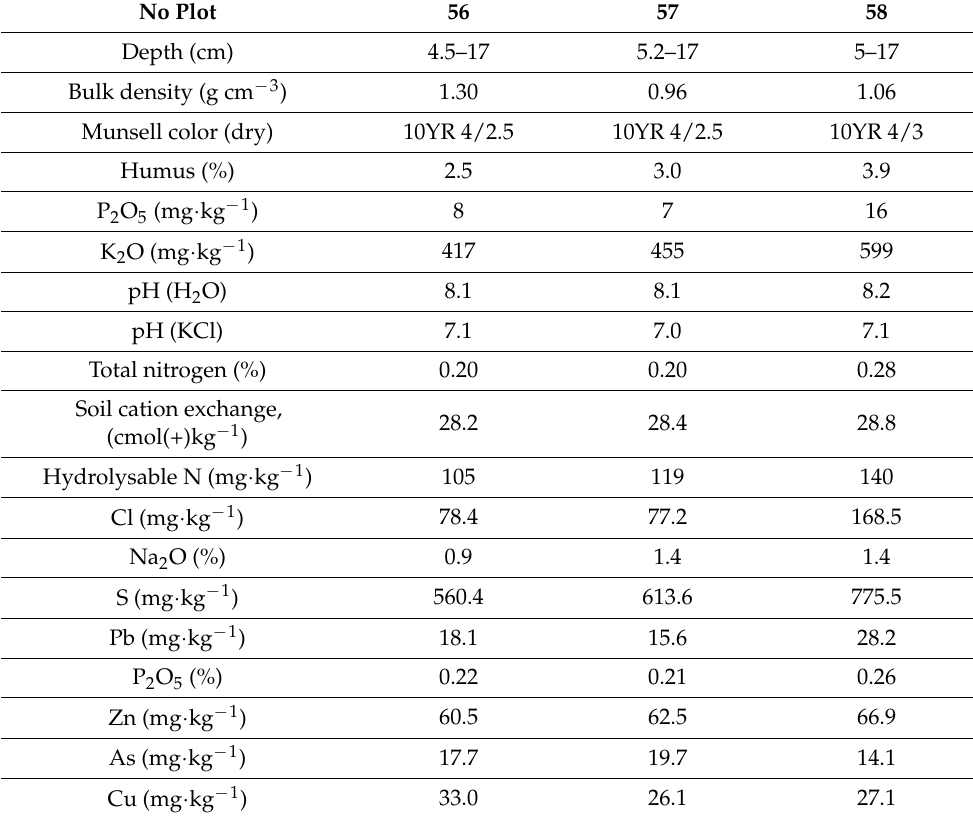
Table 1. Physicochemical and geochemical properties of the upper part of horizon